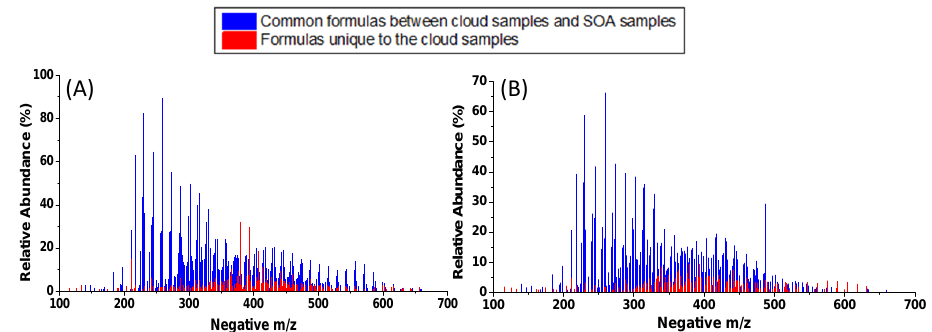
Fig. 4. Reconstructed mass spectra of the CHO compounds in CW1 (a) and CW2 (b) . Blue peaks show the common formulas between the cloud water samples and biogenic SOA samples (combined data of ozonolysis of α -pinene, β -pinene, d-limonene and β -caryophyllene); red peaks show the formulas unique to cloud water samples. Figure5